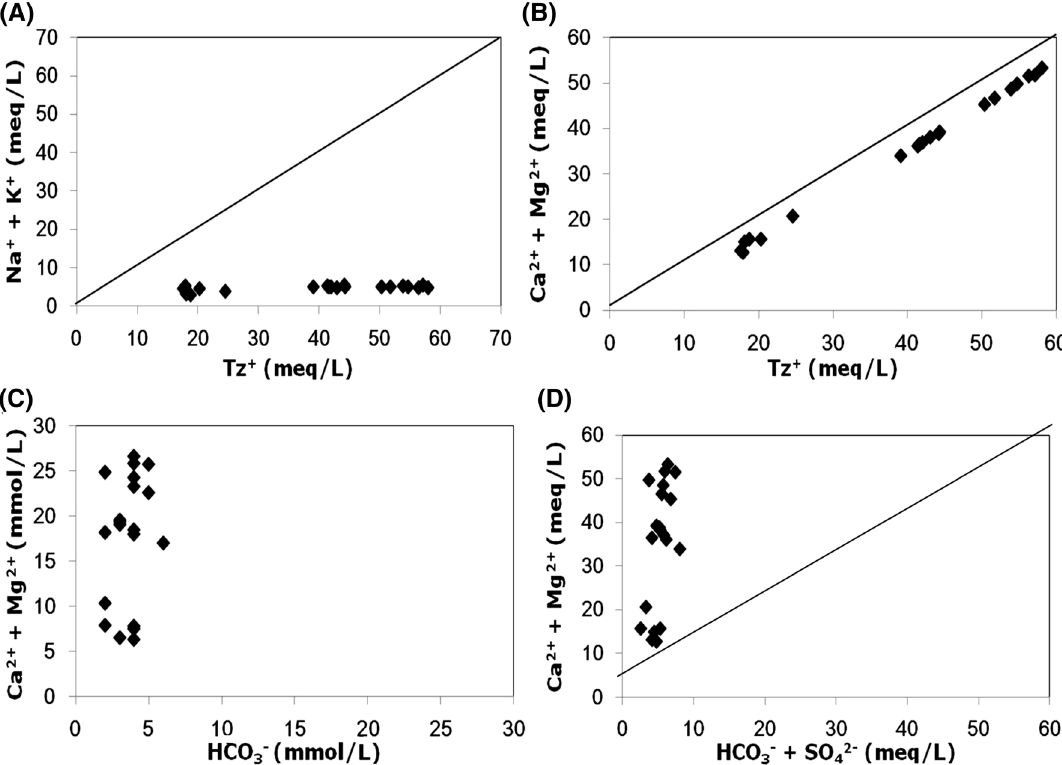
Fig. 3 Scatter plot for hydrogeochemical evolutionary process, a scatter plot between Tz + and Na + + K + , b scatter plot between Tz + and Ca 2+ + Mg 2+ , c scatter plot between HCO 3− and Ca 2+ + Mg 2+ and d scatter plot between Ca 2+ + Mg 2+ and HCO 3− + SO